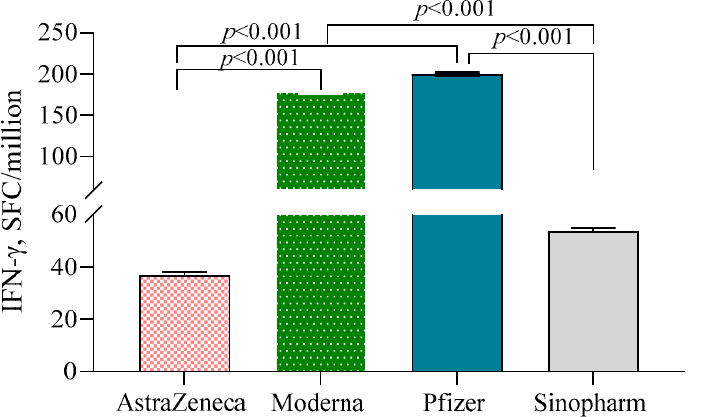
Figure 4. IFN- γ -secreting T cells in different vaccine groups. A 2-way ANCOVA was used to estimate the p -value, and the model was adjusted for age, sex, income and BMI.